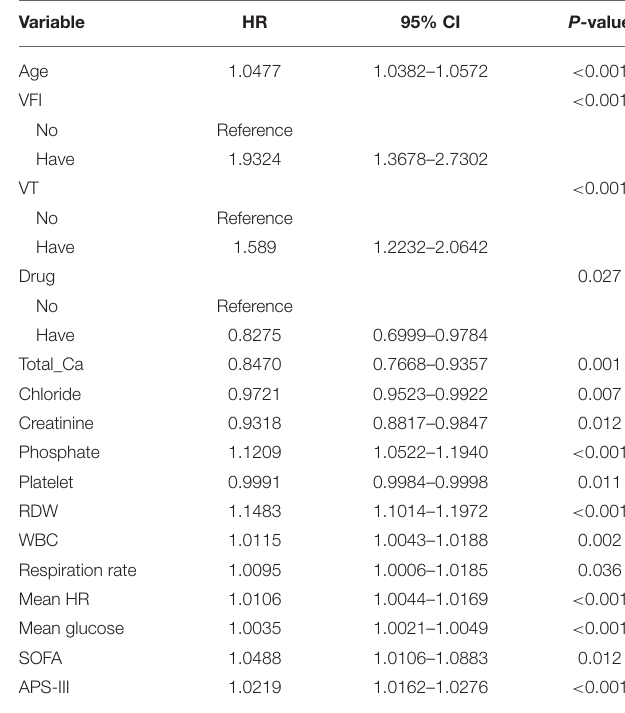
TABLE 2 | The results of cox regression